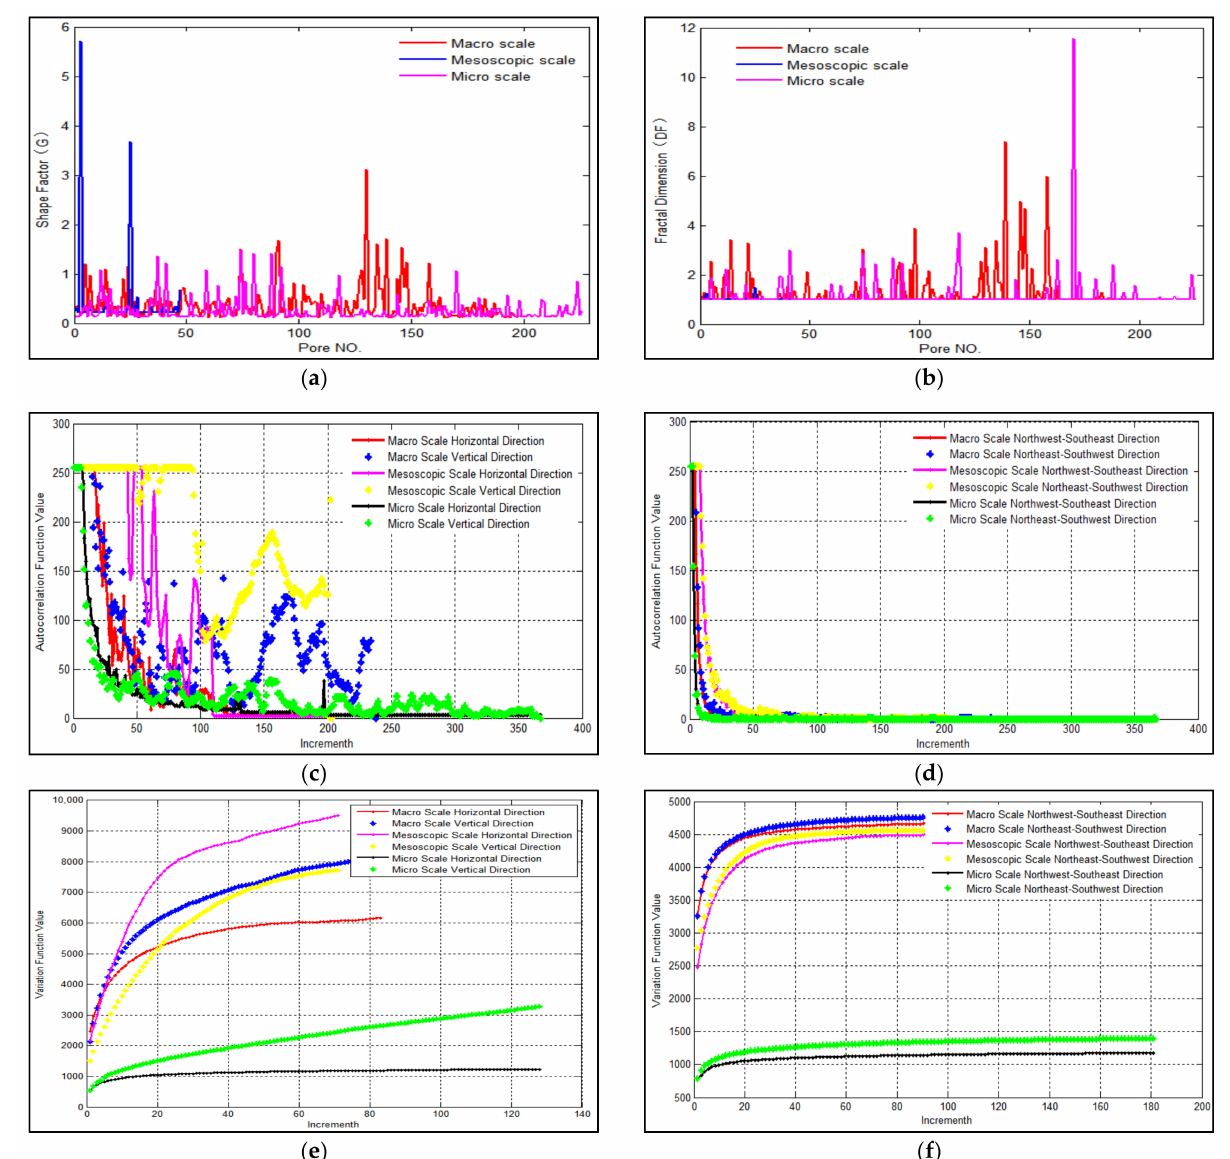
Figure 10. Numerical distribution of multi-scale pore structure characterization. ( a ) Shape factor; ( b ) Fractal dimension; ( c ) Horizontal and vertical autocorrelation functions; ( d ) Northwest–southeast and northeast–southwest autocorrelation functions; ( e ) Horizontal and vertical variation functions; ( f ) Northwest–southeast and northeast–southwest variation